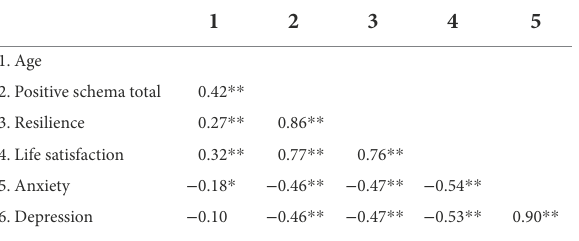
TABLE 2 Correlation analysis of continuous